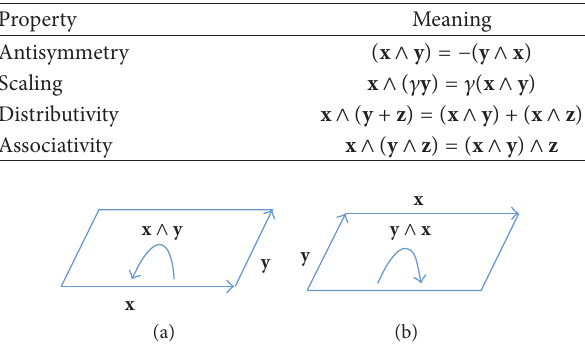
Figure 1: The geometry of outer product (a) x ∧ y and (b) y ∧ x .